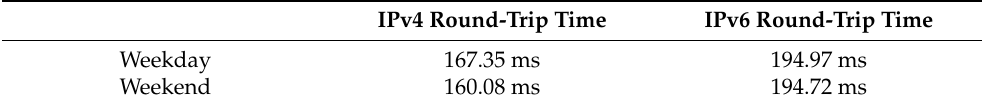
Table 6. Round-trip time results.